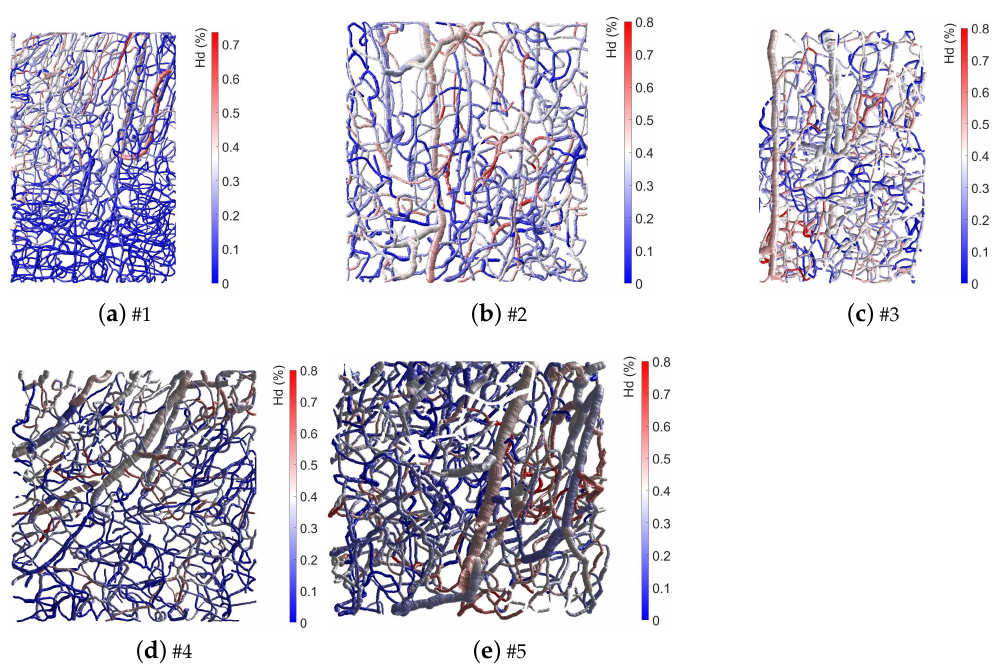
Figure 8. Computed hematocrit (in [%]) within the 5 cerebrovascular regions of the murine cortex. The heat map represents by colors the hematocrit percentage per segment within the microcirculatory synthetic